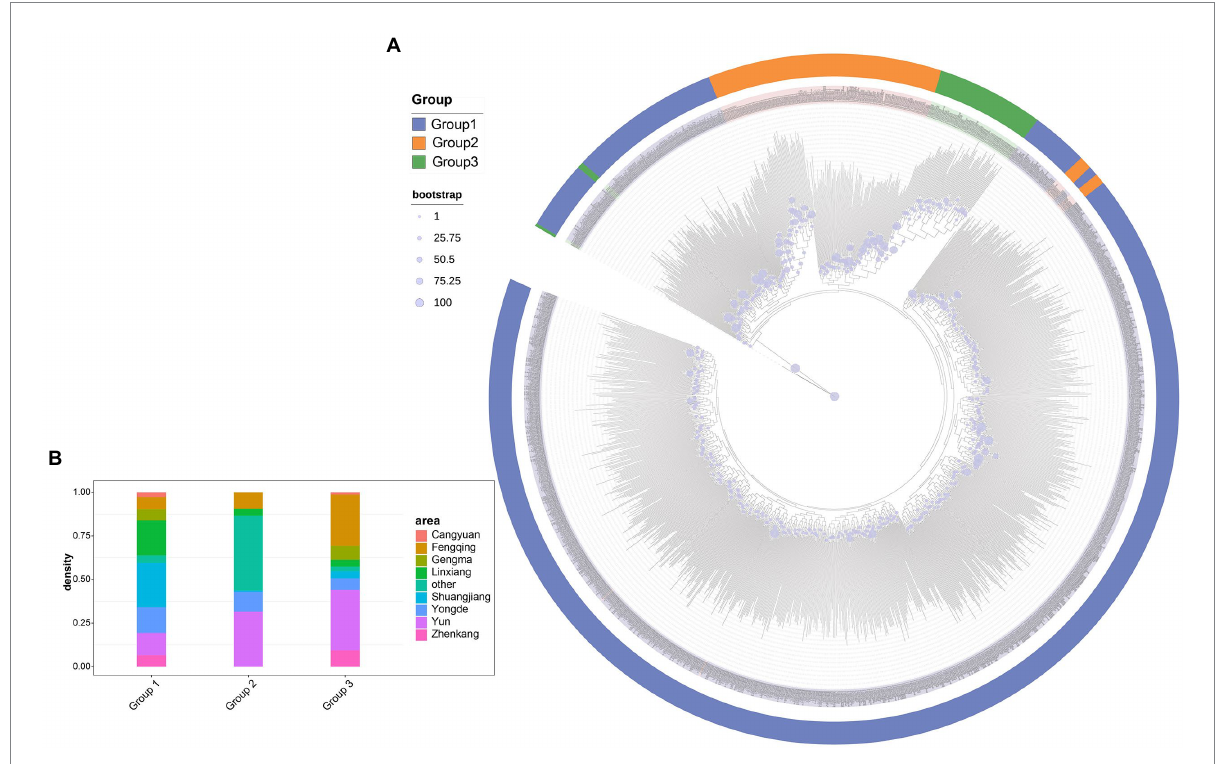
FIGURE 3 (A) Phylogenetic relationships of 1,350 ancient tea plants in three subgroups. Deep blue, orange, and green represent group 1, group 2, and group 3. Bootstrap values are indicated by blue circles. KM6 ( C. Cuspidata ) was selected as the outgroup. (B) The region distribution of accession from different tea plant subpopulations.